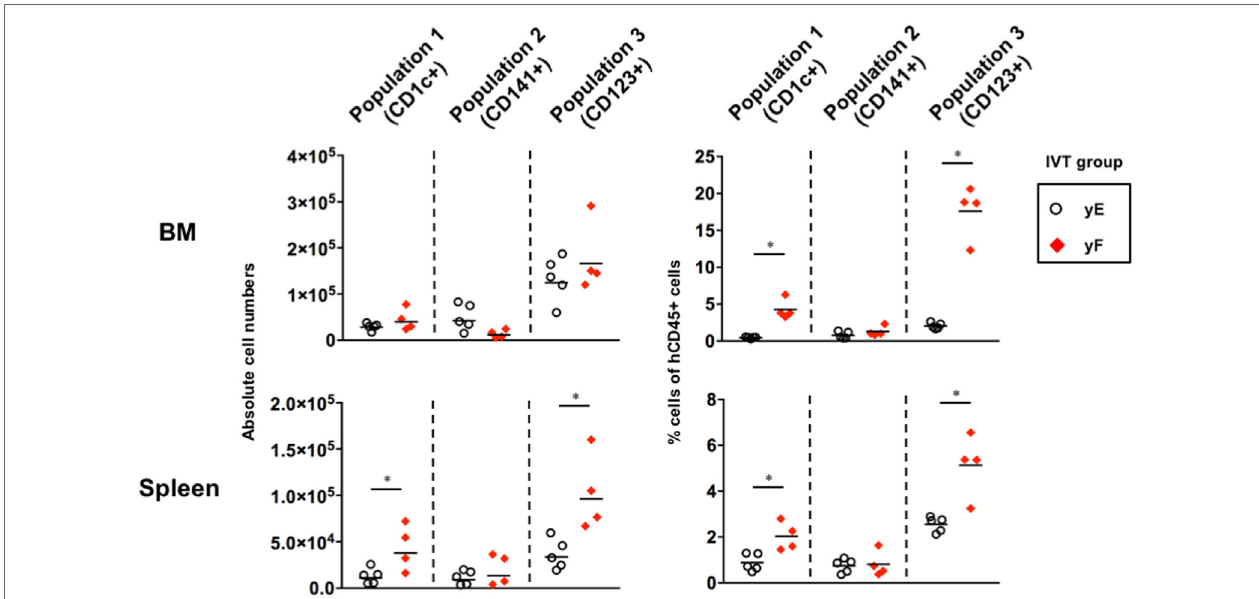
FigUre 5 | Effect of fms-related tyrosine kinase 3 ligand (Flt3-L) on the reconstitution of putative dendritic cell populations in the young hNOJ mice. Four-week-old hNOJ mice were subjected to in vivo transfection (IVT) with either the Flt3-L-expressing plasmid (Group yF) or the empty vector plasmid (Group yE). The absolute cell numbers (left panels) and the percentages (right panels) of CD1c + population (Population 1), CD141 + population (Population 2), and CD123 + population (Population 3) in the bone marrow (BM) (upper panels) and spleen (lower panels) are shown. Data are the individual values (Group yE: n = 5, Group yF: n = 4) with the geometric means of the absolute cell numbers (left panels) or means of the percentages (right panels). Significant differences (* P < 0.05) were determined by the Mann–Whitney U